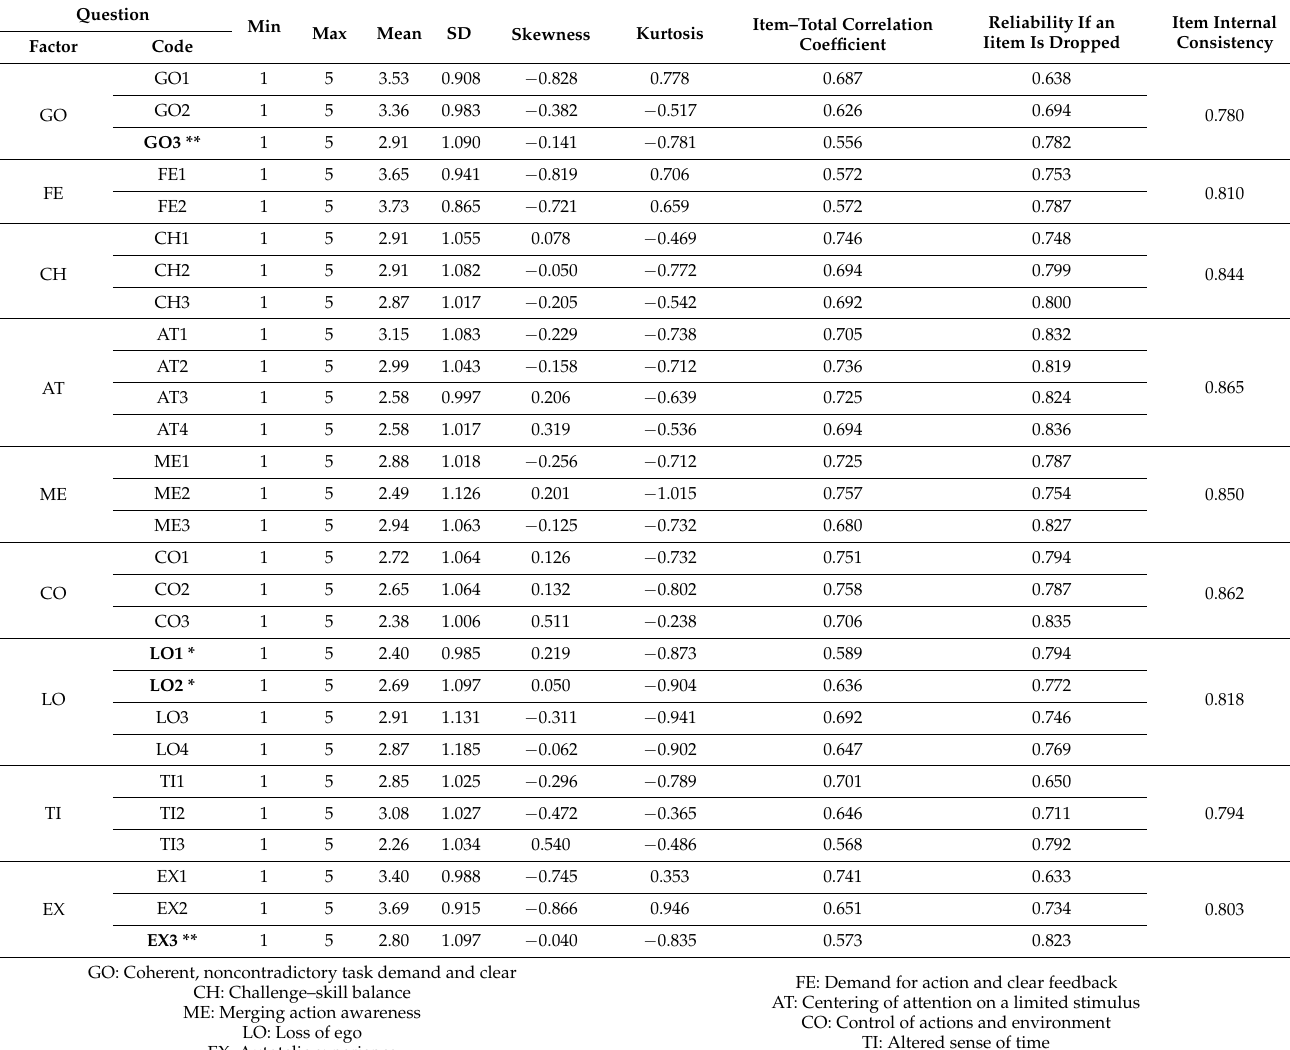
Table 2. Descriptive statistics and internal consistency in the exploratory factor analysis of TS-FSS ( n =